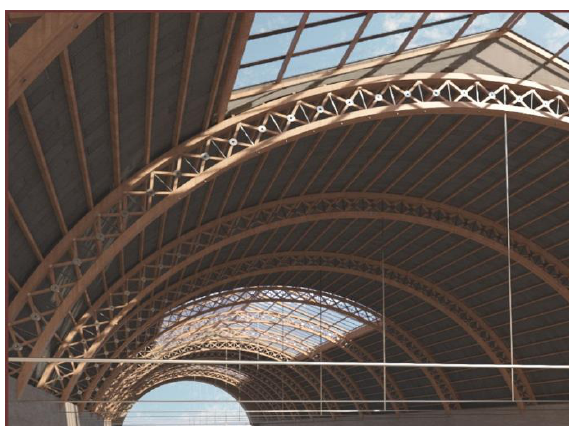
Figure 6. Render of the train gallery roof